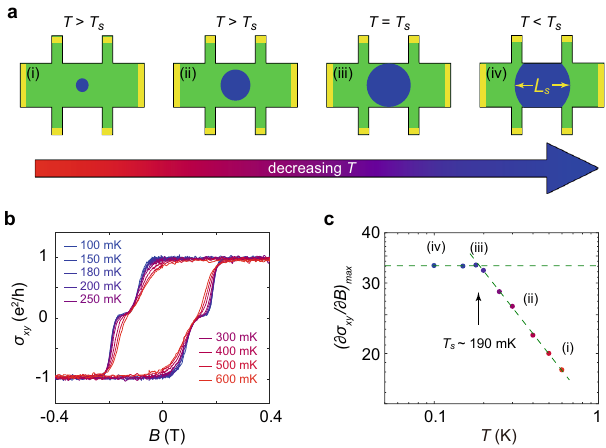
Fig. 4 Saturation of ( ∂ σ xy / ∂ B ) max in the quantum critical regime at low temperatures for a 5- μ m QAH device. a Illustration of L s at different temperatures, green regions represent the area of the Hall-bar device and blue regions indicate the length scale of L s . From scenario s (i) to (iii), L s grows as the temperature is lowered. In s cenario (iii), L s is comparable to the physical size of the Hall-bar device. In scenario (iv), L s is limited by the physical size. b Field dependence of σ xy at different temperatures, all curves were measured with a 0.5 nA current. c Temperature dependence of ( ∂ σ xy / ∂ B ) in the quantum critical regime. The scaling behavior saturates max at ~190 mK, indicating L s reaches the physical size of the sample at this temperature. (i)-(iv) correspond to the scenarios illustrated in a